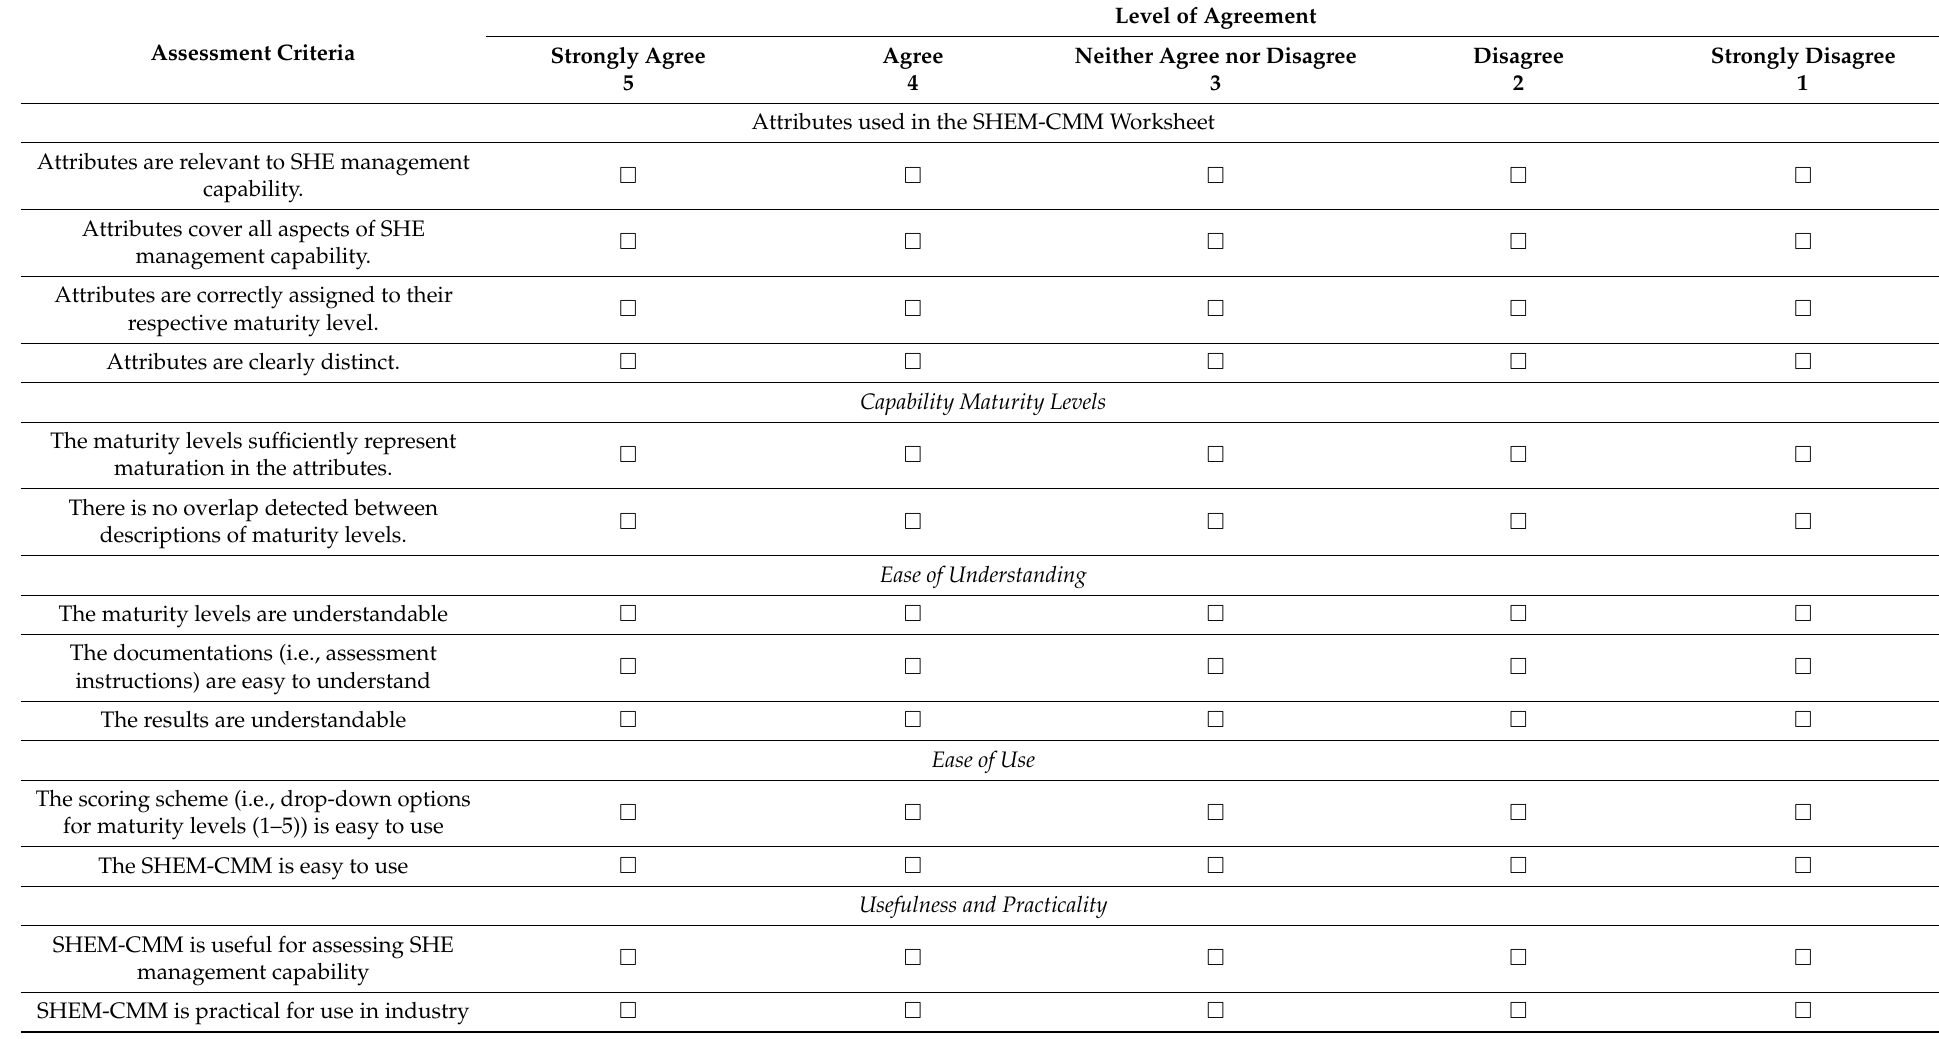
Table A2. Evaluation